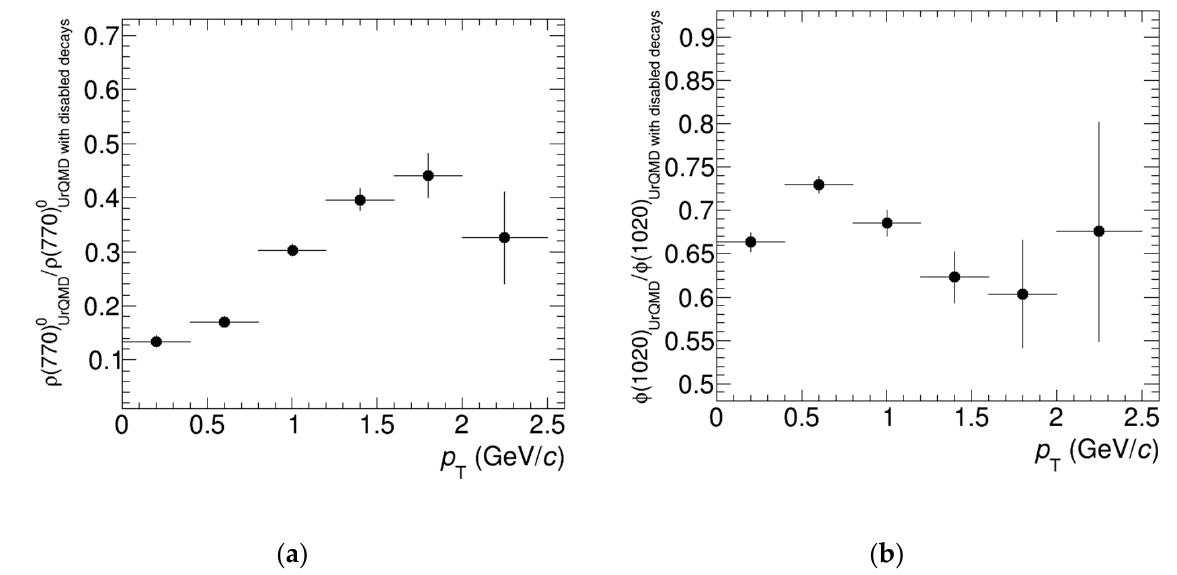
Figure 1. Ratios of p T -differential yields estimated for ρ (770) 0 ( a ) and φ (1020) ( b ) mesons using the two different approaches described in the text. The results are obtained using the UrQMD [11] event generator in Au+Au collisions at √𝑠 (cid:3015)(cid:3015) = 11 GeV.